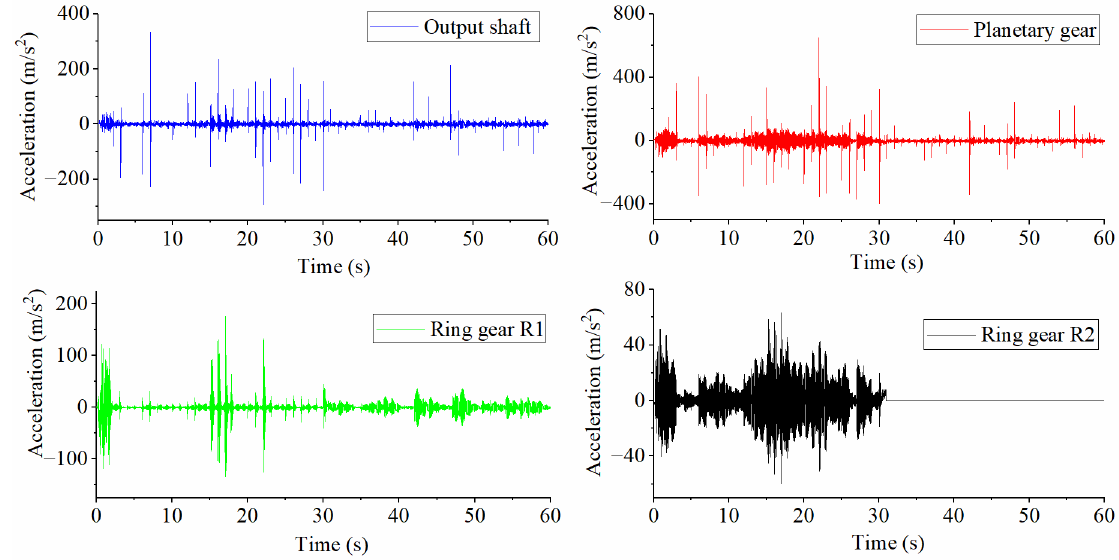
Figure 17. Waveforms of the output shaft, planetary gear, ring gear R1, and ring gear R2 angular accelerations.